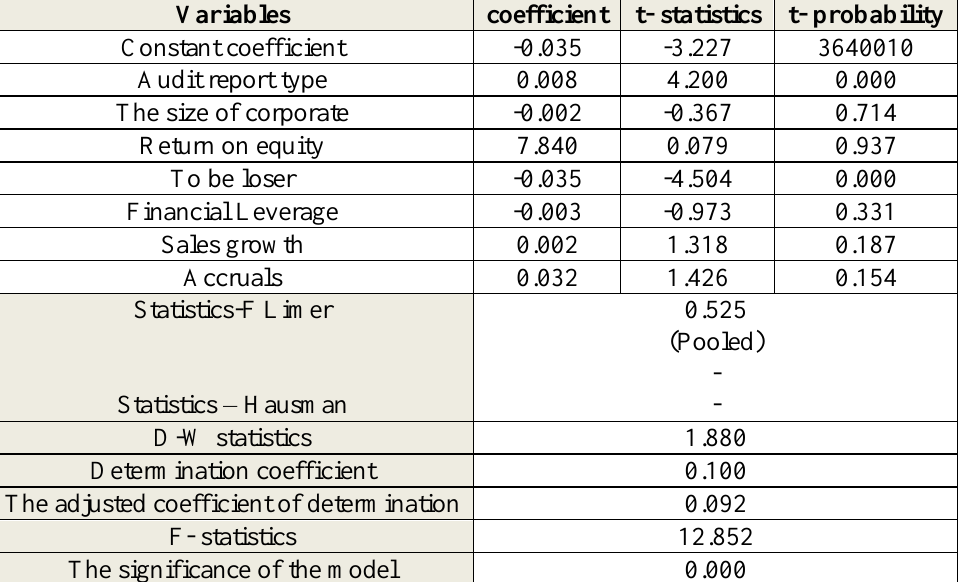
Table 4: Test results of the first